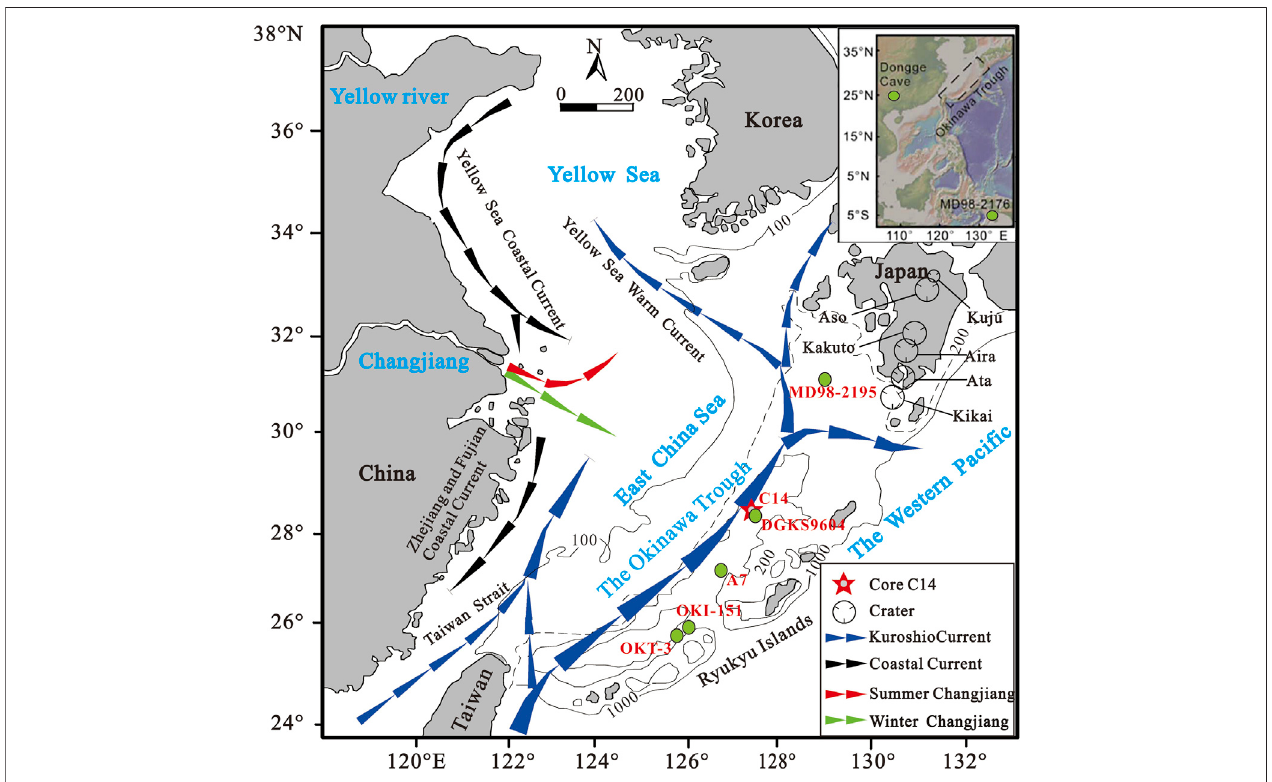
FIGURE1| LocationofcoreC14inthemiddleOkinawaTrough(OT)andselectedpaleoenvironmentalsettings,includingDonggeCaveinsouthernChina(Dykoski etal.,2005),coreMD98-2176inthewesterntropicalPaci fi c(Stottetal.,2004),coresA7(Sunetal.,2005)andDGKS9604(Yuetal.,2009)inthemiddleOT,coresOKT- 3 (Zhao et al., 2015) and OKI-151(Xuet al., 2018) in thesouthernOT,and coreMD98-2195 (Yamamoto et al.,2013)in the northern OT.The map was revised from Dou et al. (2010). The Contour unit is meter. Volcano locations around Japan were modi fi ed according to Machida (1999).